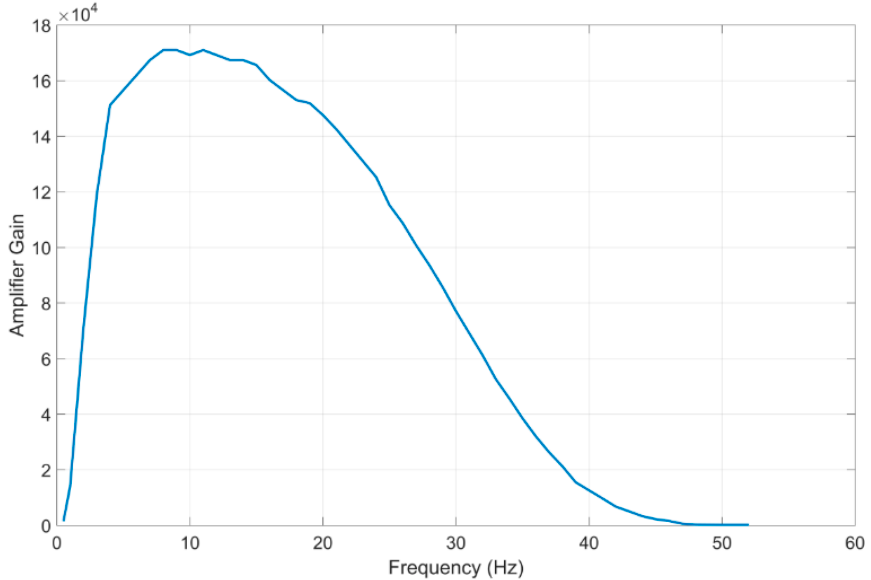
Figure 8. Measured magnetic coil (antenna) sensitivity against frequency along with the corresponding best linear fit line.